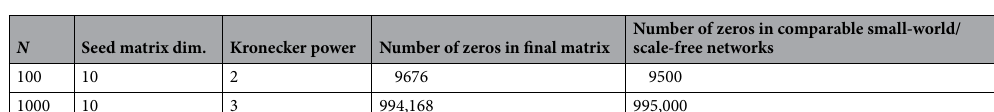
Figure 3. Stabilization of different Kronecker–Leskovec networks. The network size in ( a , b ) is N 1000 . The self-coupling strengths for ( a , c ) were drawn from an interval with fixed size 0.9 and in ( c , d ) N = varying position, and for ( b , d ) from an interval with varied lower bound and upper bound fixed at stabilization parameter µ or µ ∗ and the Hill fit parameters (cf. Eq. (1)) are provided next to the graphs. Each data point represents the average over 1000 trials. Error bars indicate the standard deviation estimated as described in “Methods”.